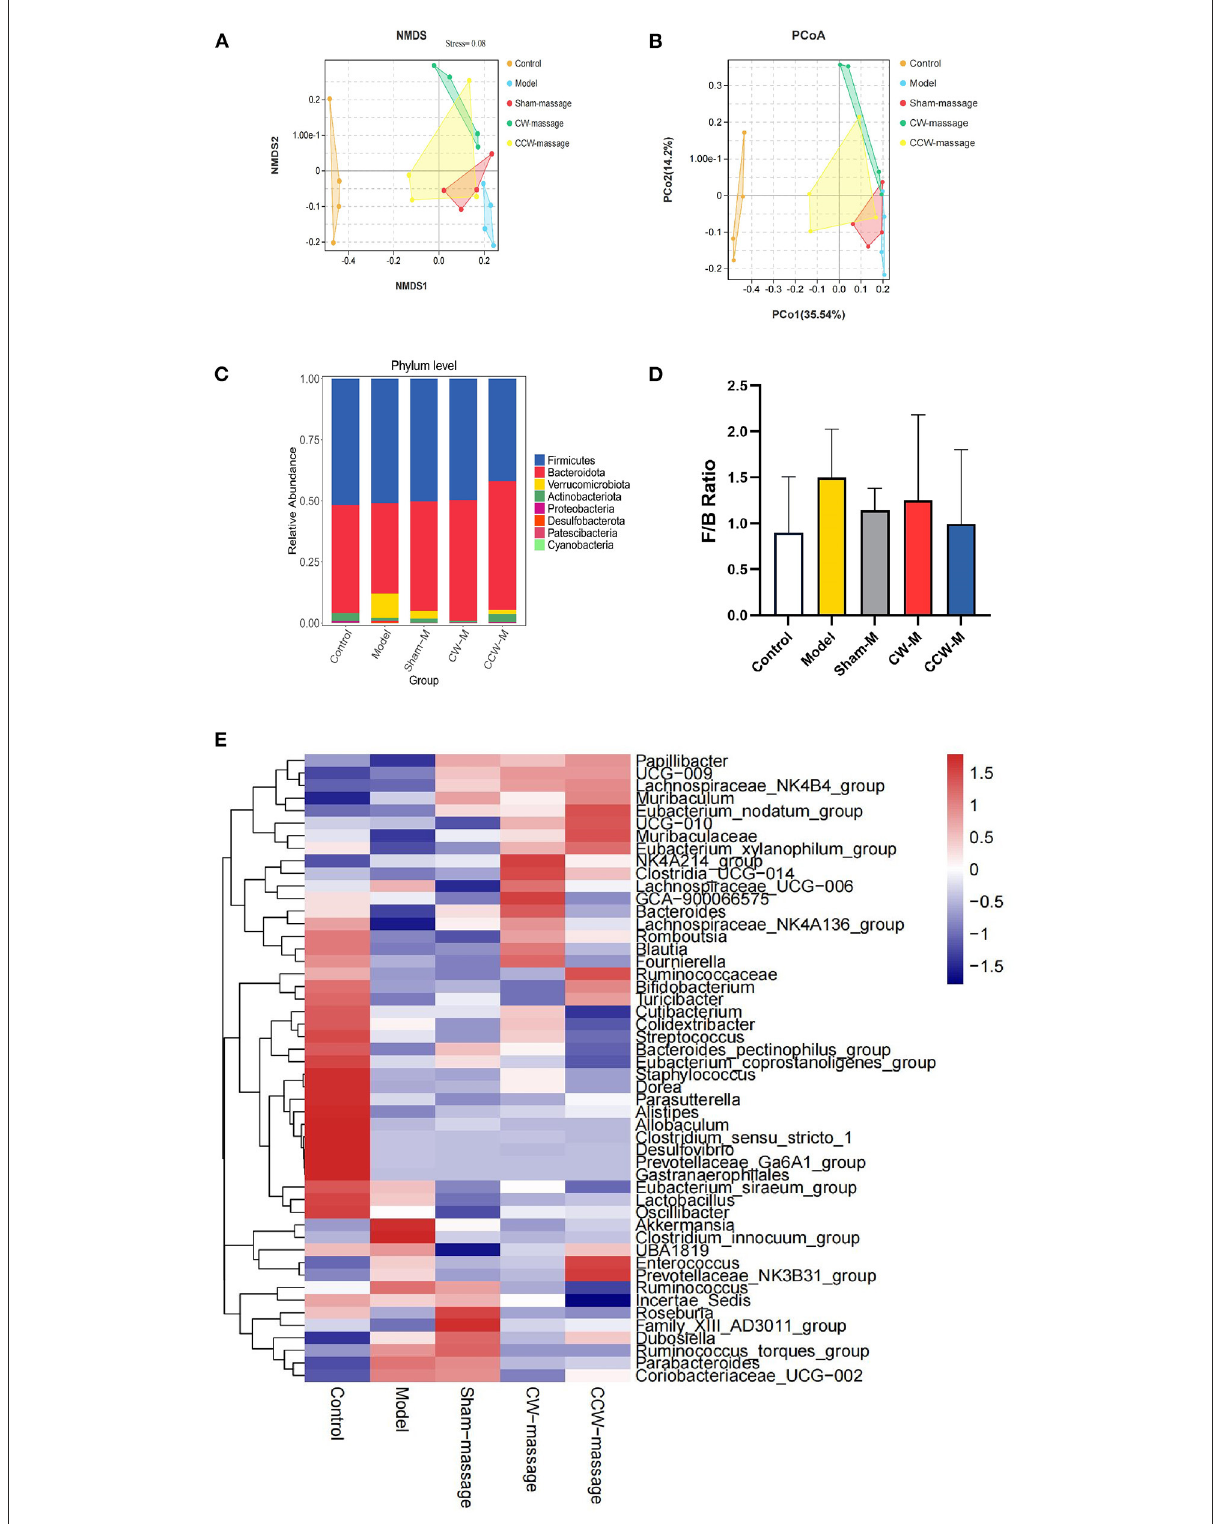
FIGURE4 (A) NMDS plot of Bray-Curtis dissimilarity, Stress = 0.08. (B) PCoA plot of Bray-Curtis dissimilarity. (C) Relative abundance of ASVs at phylum level. (D) F/B Ratio in each group. Error bars are expressed as means ± SD ( n = 4). Statistical significance was determined by one-way ANOVA with Tukey tests for multiple-group comparisons. (E) Heatmap of relative abundances at the genus level [top